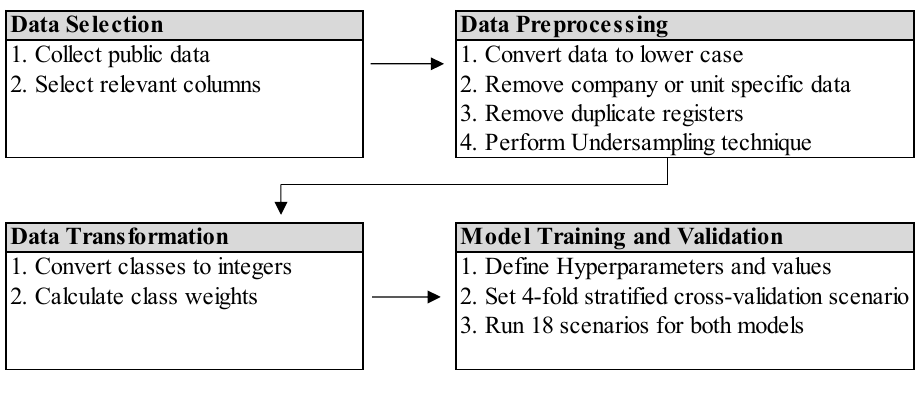
Figure 4. Procedures. Figure 4.